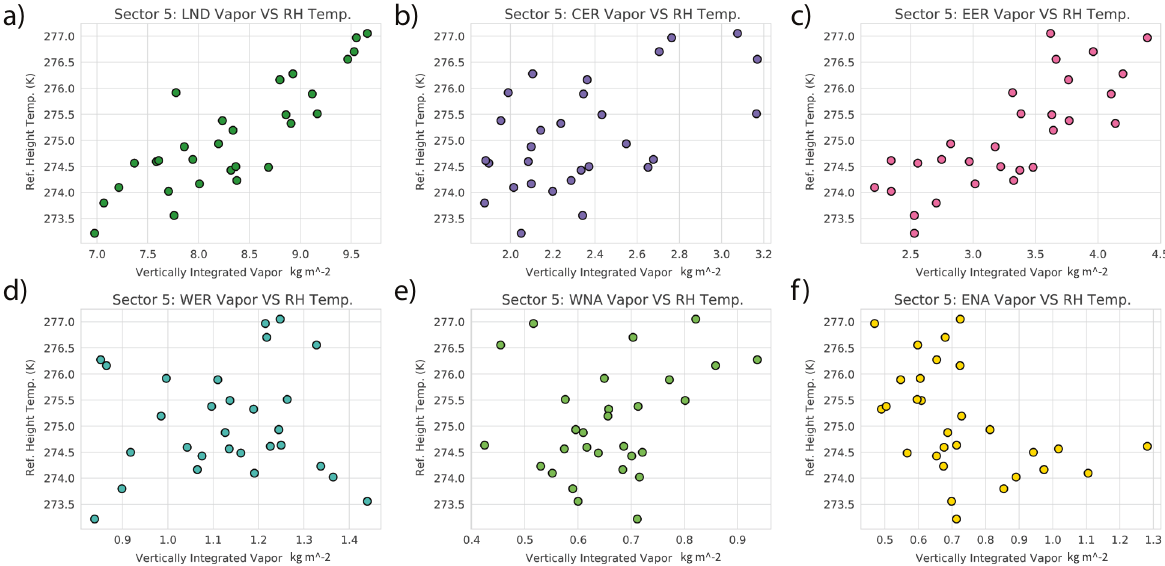
Fig. 6 Sector 5 near-surface temperature correlation to land vapor of different source origins. The relationship between near-surface temperatures in Sector 5 and ( a ) vertically integrated land vapor and ( b – f ) vertically integrated land vapor from each longitudinally de fi ned land region (see Fig.